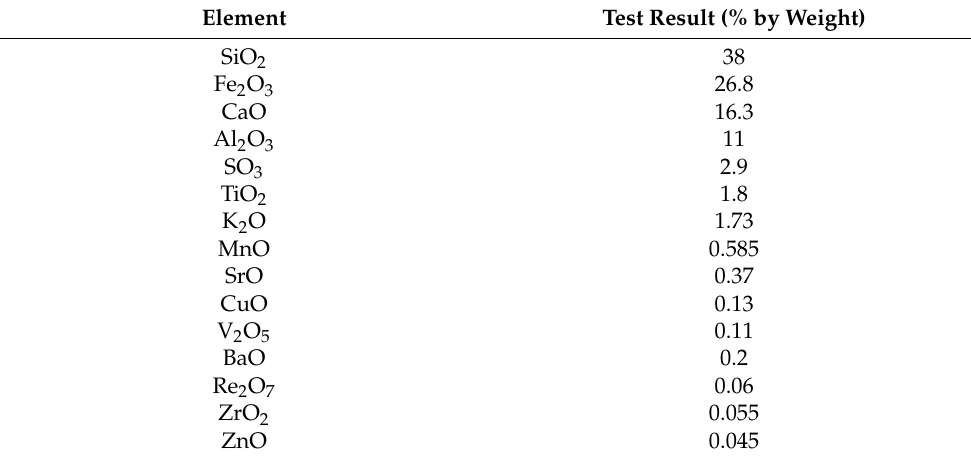
Table 2. Chemical composition of RAP [33]. Element Test Result (% by Weight) SiO